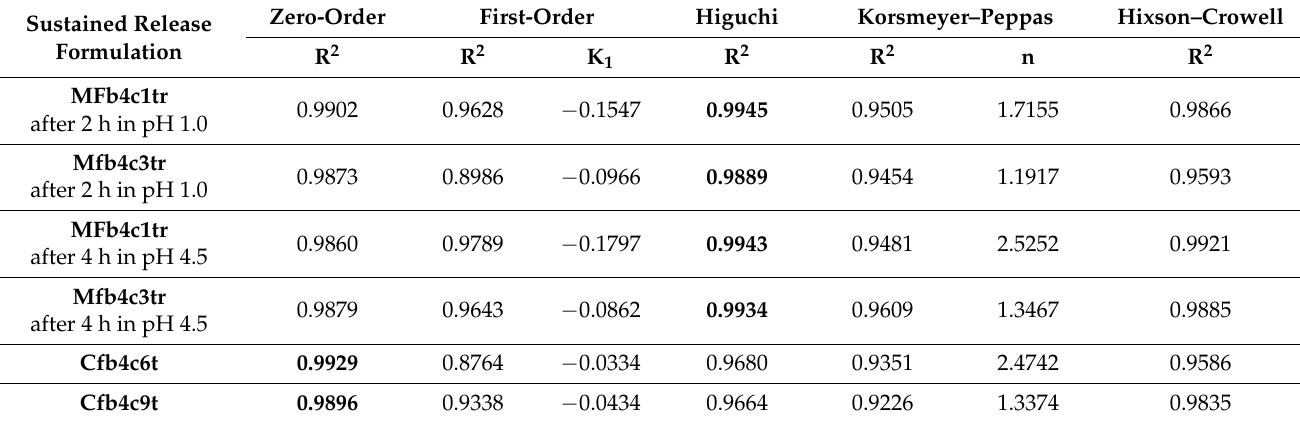
Table 4. Results of mathematical models of release kinetics (zero-order, first-order,